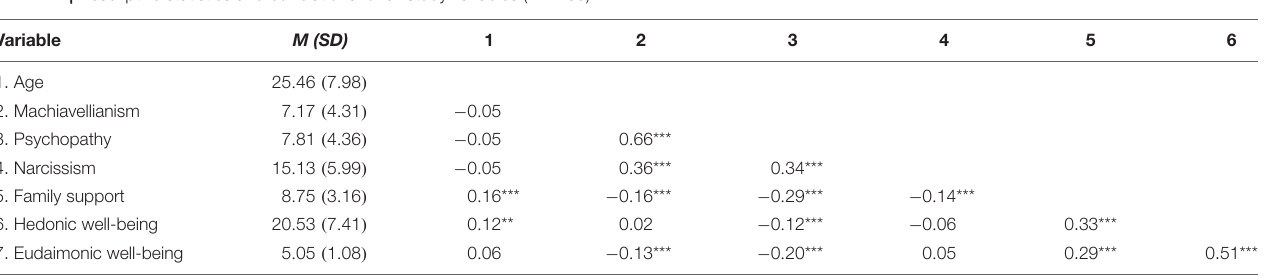
TABLE 1 | Descriptive statistics and correlations for all study variables ( n = 705).